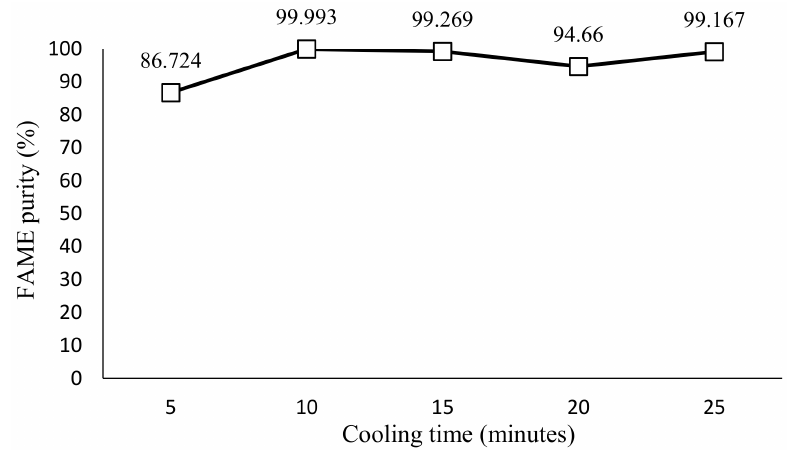
Figure 4. FAME purity against cooling times. Table 2. Observation for the effect of cooling times in